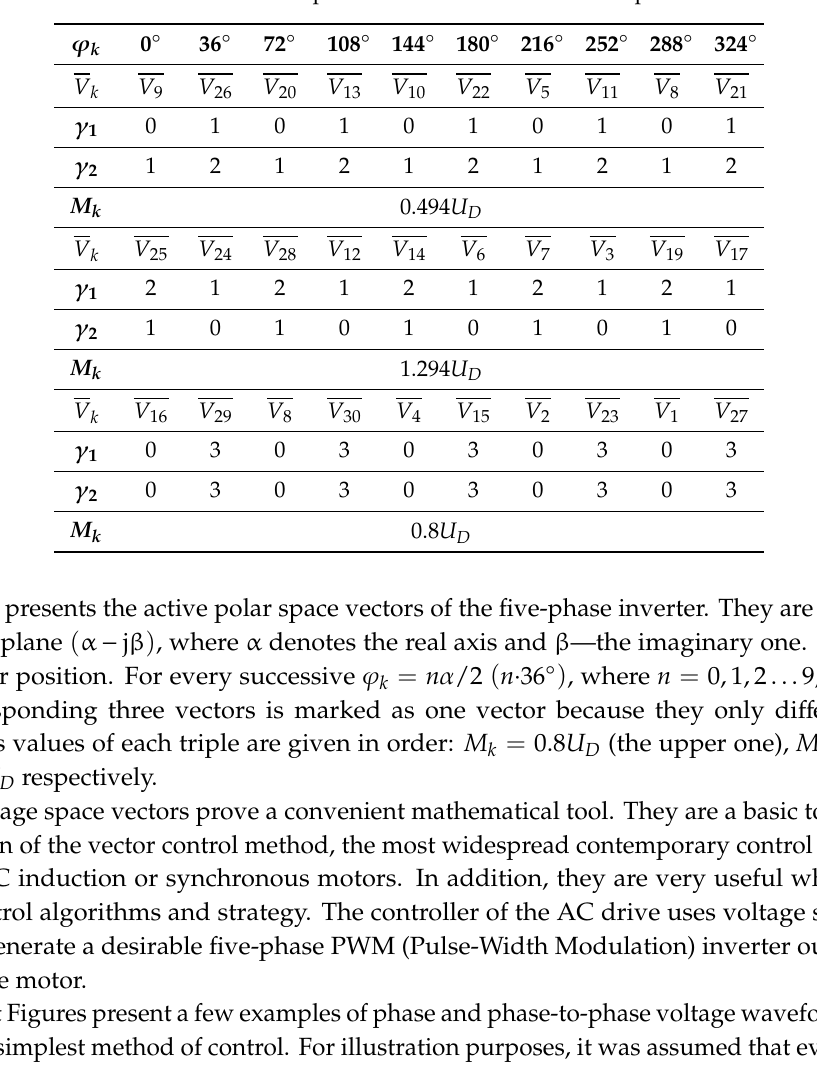
Table 1. The active vectors’ parameters of the two-level five-phase